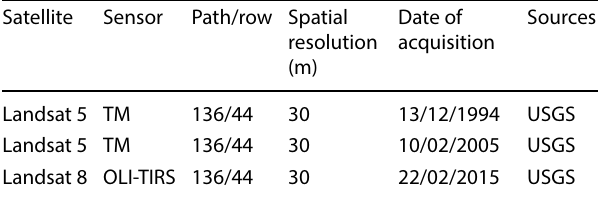
Table 1 The characteristics of the Landsat data used in this